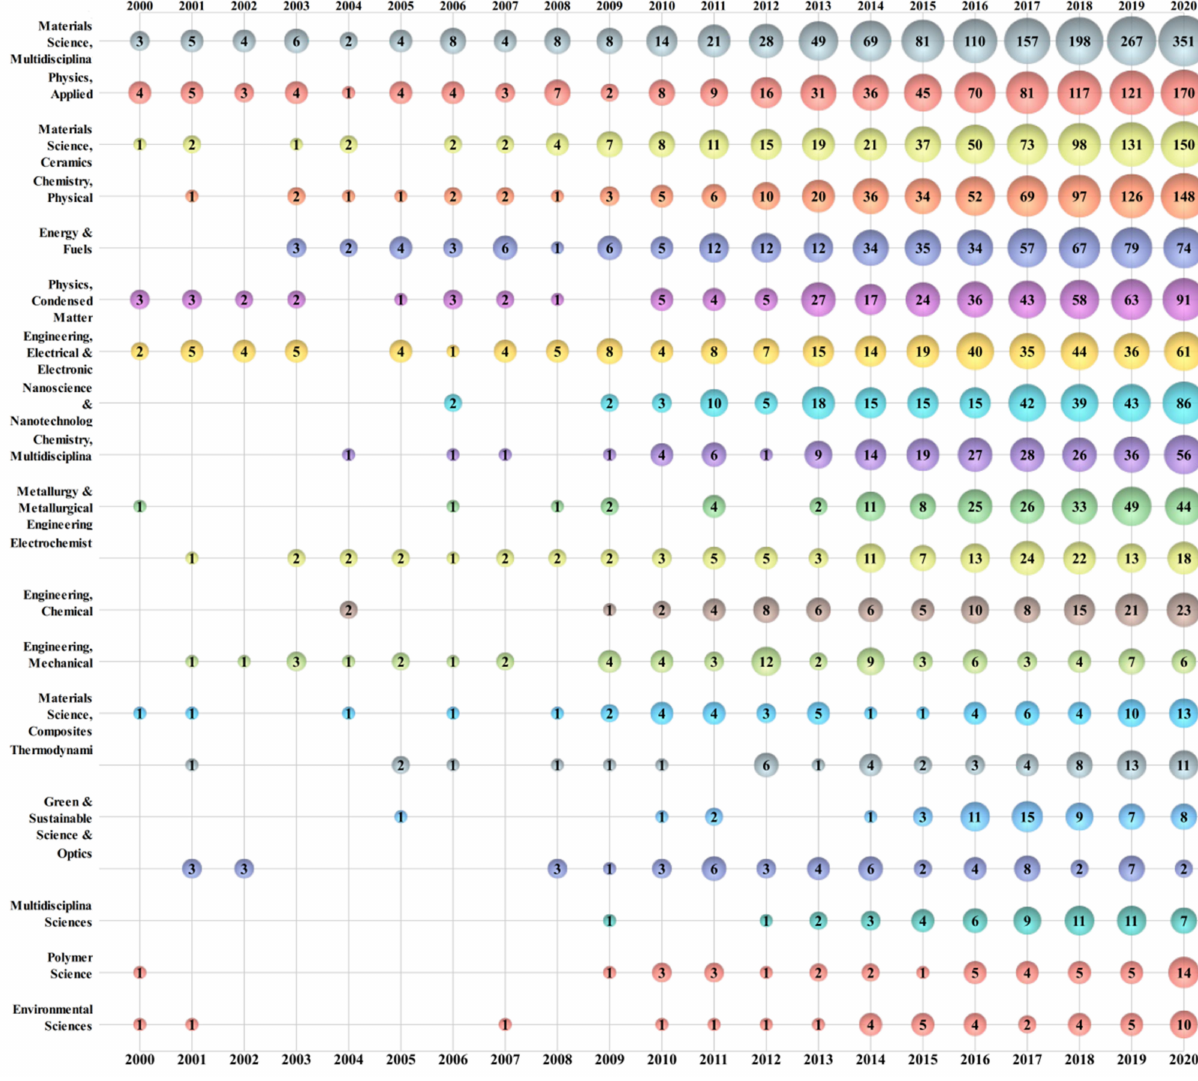
Figure 4. Bubble chart of the top 20 research areas in energy storage